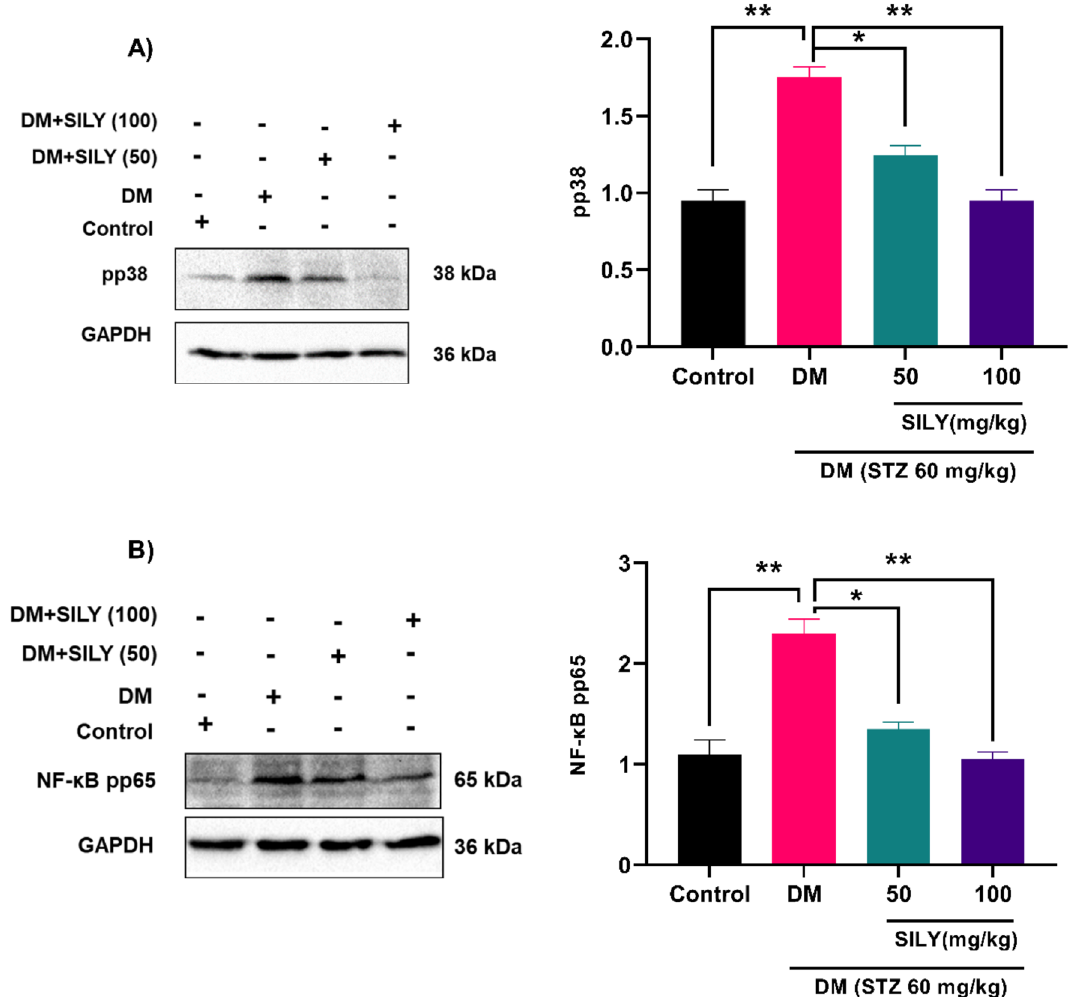
Figure 5. Silymarin attenuates ( A ) p38 MAP kinase and ( B ) NF-κB p65 phosphorylation in the retina of diabetic rats. Western blotting was applied to quantify p38 MAP kinase and NF-κB p65 phosphorylation. Data are reported as mean ± SD. The differences between groups were compared using one-way ANOVA and Tukey’s post hoc test. Eight animals in each group were utilized for this experiment. The original blots were presented in Supplementary Fig. S2A,B. * and ** showing p < 0.05 and p < 0.01, respectively. DM: diabetes mellitus; SILY: